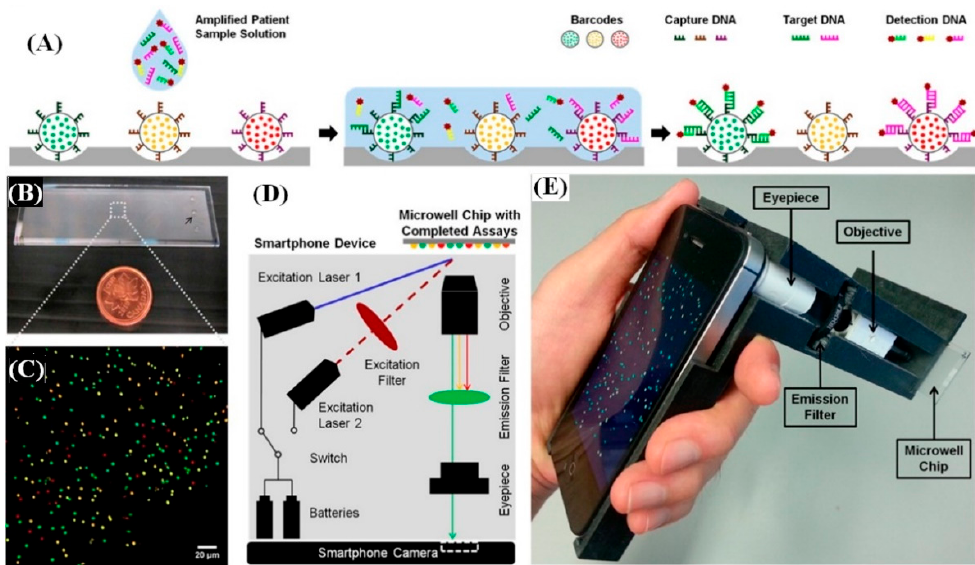
Figure 5. ( A ) Schematic of the fluorescence assay for detecting multiple pathogens, using a smartphone: The sample was added to a chip coated with microbeads, which are optically barcoded by quantum dots and are coated with bio-recognition element to capture a specific target molecule; ( B ) Photograph of the microwell chip containing different barcodes in each well; ( C ) Fluorescence image of the different quantum dot barcode array (Scale bar—20 µm); ( D ) Schematic of the quantum dot barcode array (Scale bar—20 µ m); ( D ) Schematic of the smartphone device. Two excitation smartphone device. Two excitation sources were used to excite the quantum dot barcoded chip sources were used to excite the quantum dot barcoded chip independently. The optical emission independently. The optical emission is collected by a set of objective and eyepiece lenses and filtered using a long-pass filter and then imaged, using a smartphone camera; ( E ) Photograph of the smartphone device incorporated with the microwell chip. Used with permission, from Reference